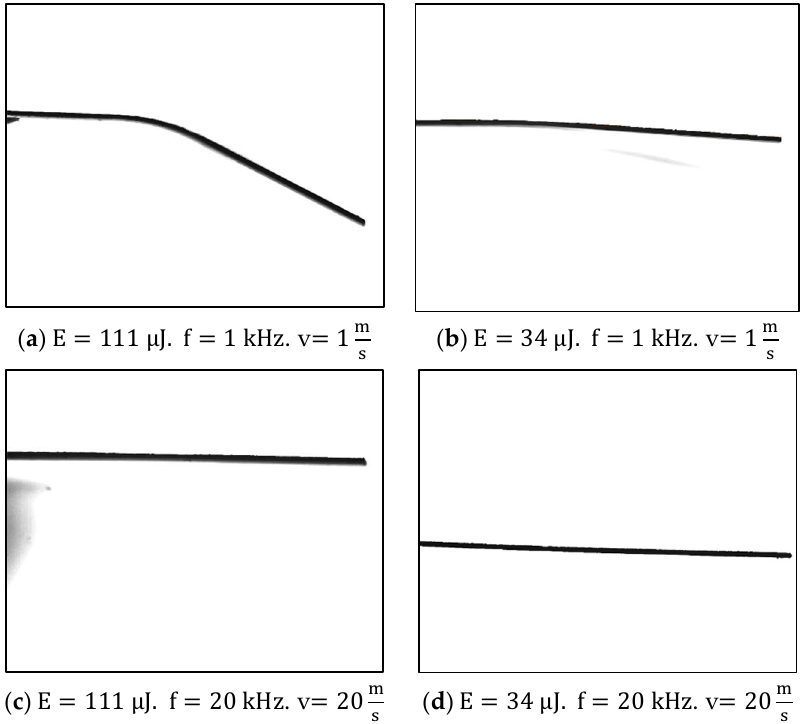
Figure 10. Low repetition rate (1 kHz) and different energies (( a ) 111 μJ and ( b ) 34 μJ ) compared to high repetition rate (20 kHz) with the same energies (( c ) 111 μJ and ( d ) 34 μJ ). Configuration a. induces bending while the others, either by using little energy or by using a high repetition rate, do not produce measurable bending.